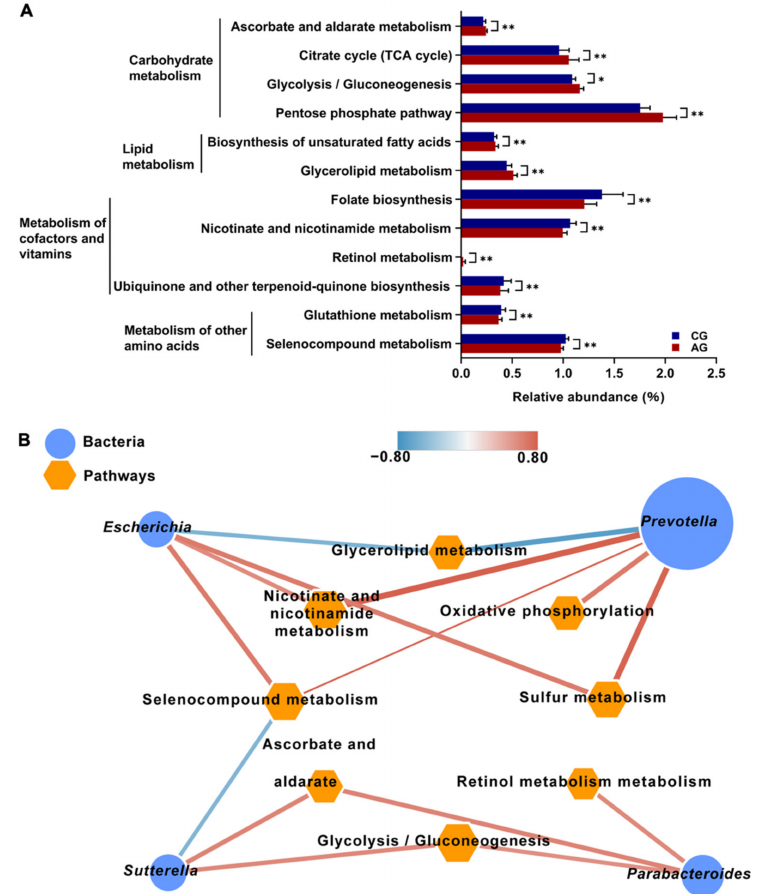
Figure 9. Functions of the gut microbiota of mice. ( A ) Relative abundance of KEGG level-3 metabolic pathways showing differences between the CG and AG groups. ( B ) Correlation networks showing the relationships between differential microbial species and the differential microbial KEGG level- 3 metabolic pathways. The node size and color (red circle: differential microbial genera; orange hexagon: differential microbial metabolic pathways) are proportional to the mean relative